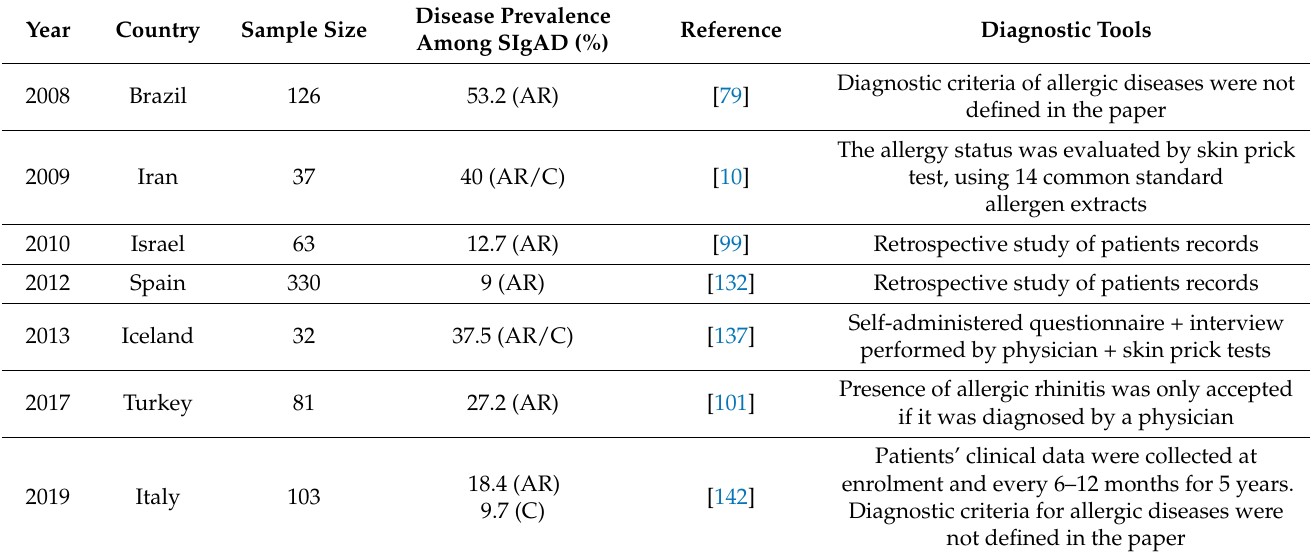
Table 4. Allergic rhinitis/conjunctivitis and